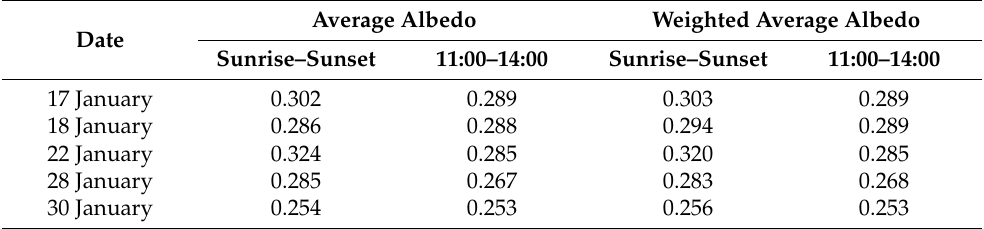
Table 3. The average albedos and weighted average albedos under different weather